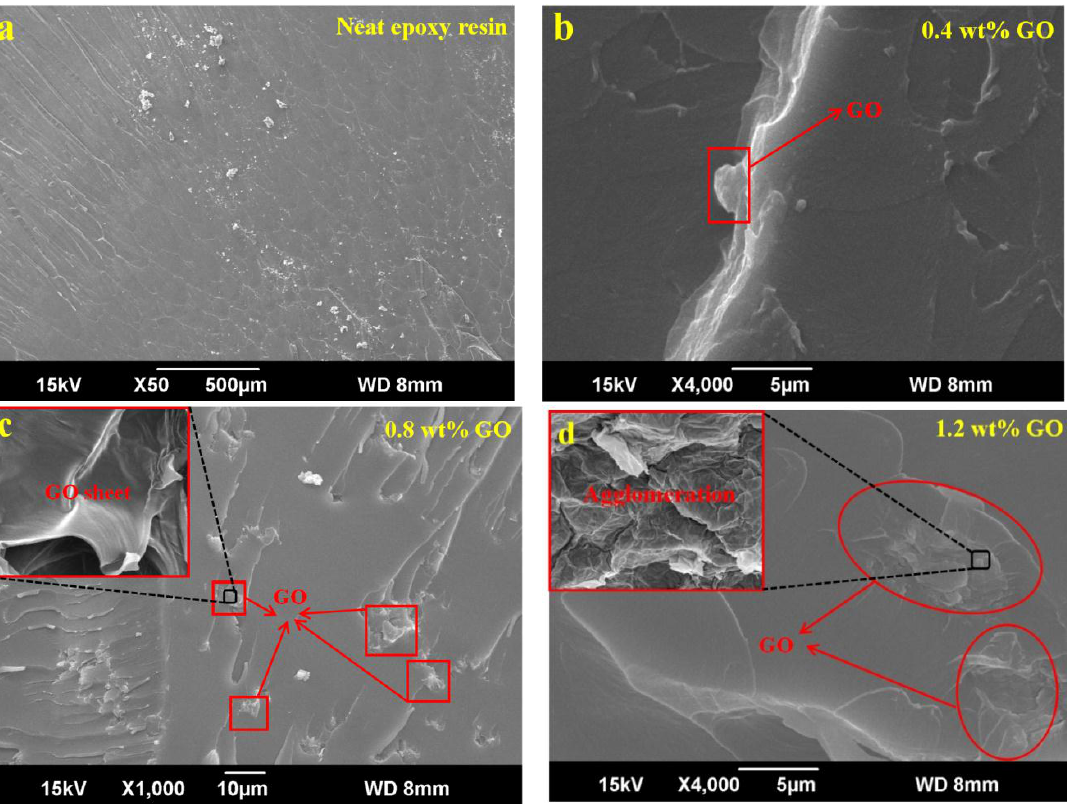
Figure 8. The SEM images of tensile fracture sections of GO/epoxy resin composites with different GO content: ( a ) neat epoxy resin, ( b ) 0.4 wt %, ( c ) 0.8 wt % and ( d ) 1.2 wt %.